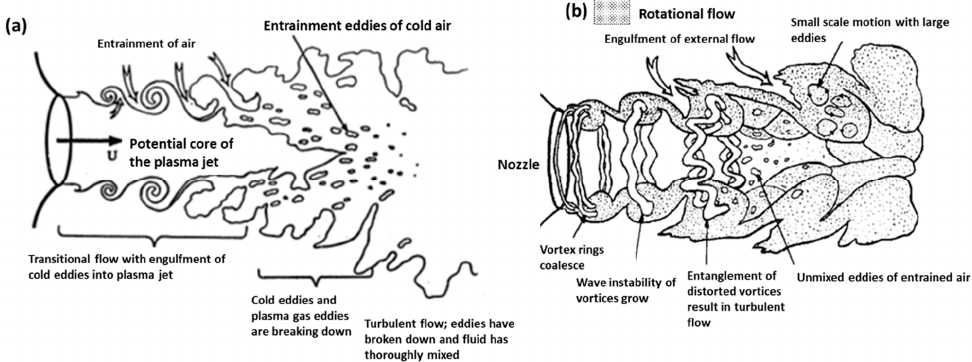
Figure 1. Schematic diagrams of: ( a ) transitional plasma jet; ( b ) rotational flow jet. Reprinted from [17] with permission from Elsevier 1989.